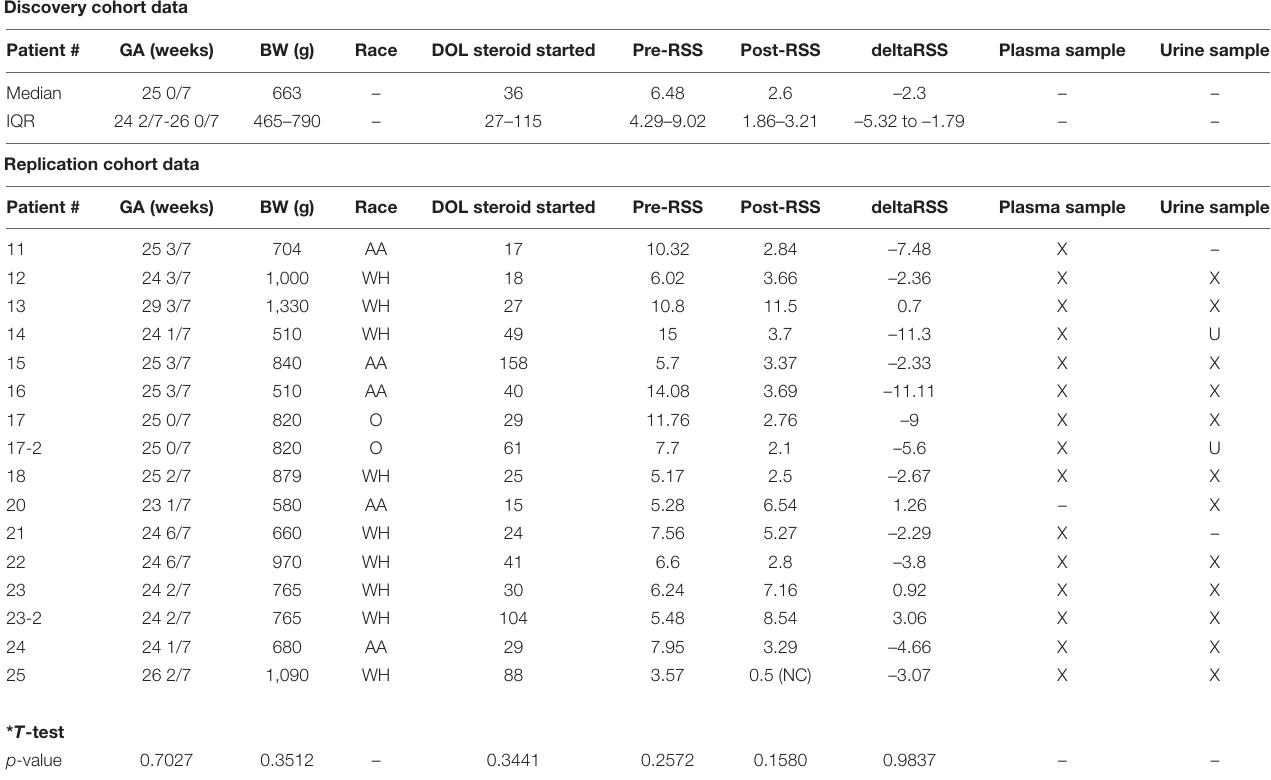
TABLE 1 | Demographics and respiratory